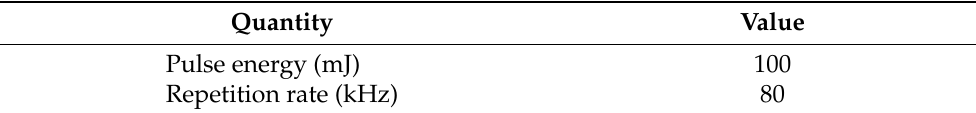
Table 16. Laser Parameters.